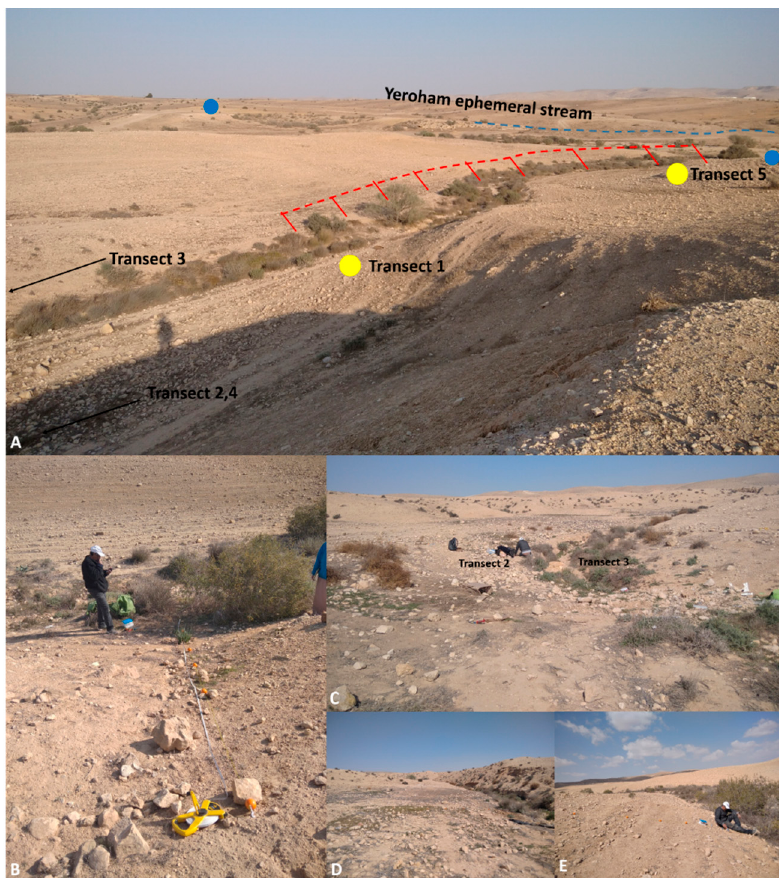
Figure 2. Wadi of study (WOS) and the analysed transects. ( A ) Far view of WOS. Red line: channel with ancient dams, blue line: ancient agriculture terrace over Yeroham ephemeral stream, blue rectangle—ancient facility (all were dated by an expert to the Byzantine era). ( B ) Slope 1, ( C ) slopes 2, 3, ( D ) slope 4, ( E ) slope 5. Table 1. Analyzed transects over WOS.